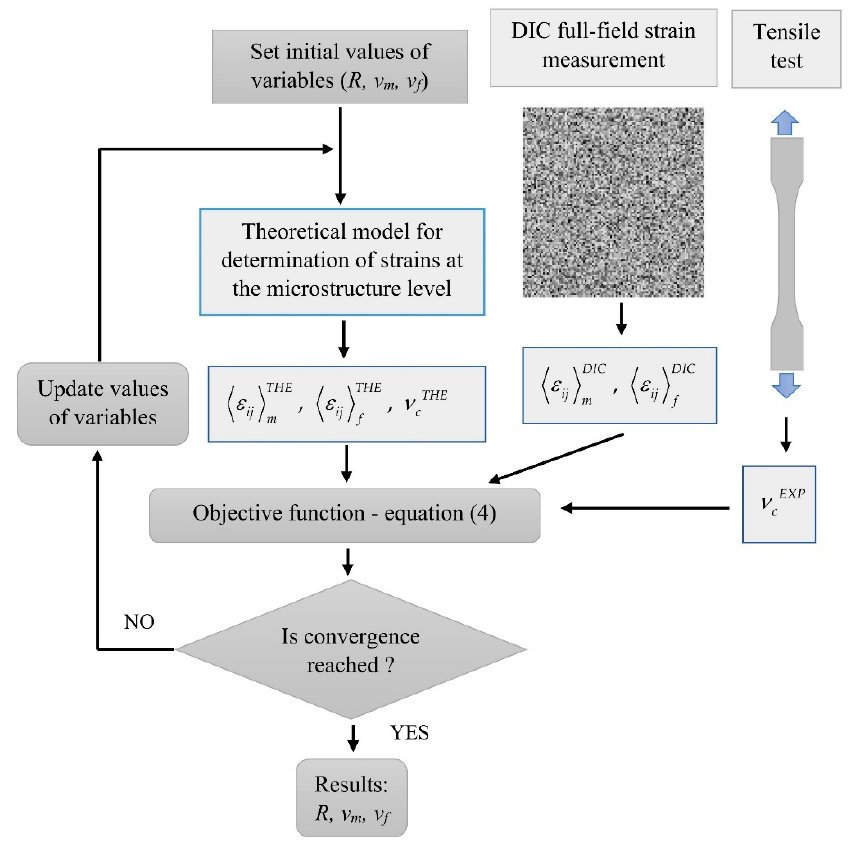
Figure 3. Scheme of the first optimization Figure 3 . Scheme of the first optimization step .